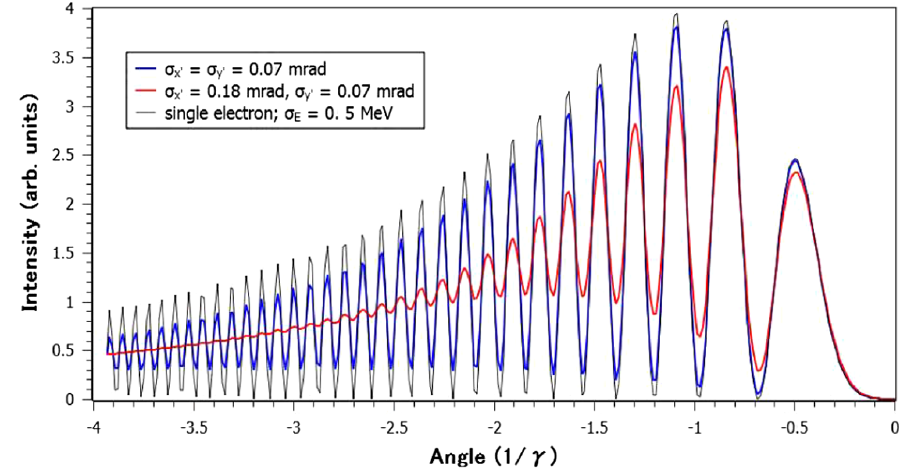
FIG. 18. Results of OTRI calculation of the effect of divergence and energy spread on interference fringes for two sources separated by distance L ¼ 100 mm; blue curve: angular divergences, σ x 0 ¼ σ y 0 ¼ 70 μ rad; red curve: angular divergences σ x 0 ¼ 180 μ rad, σ ¼ 70 μ rad; black curve: single electron and beam of electrons with energy spread σ y 0